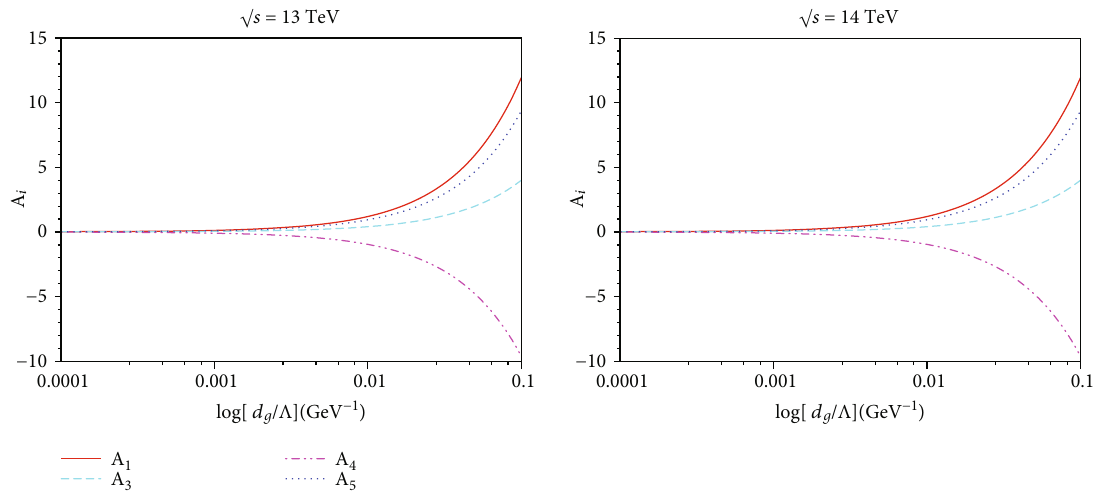
Figure 10: Asymmetries vs. d